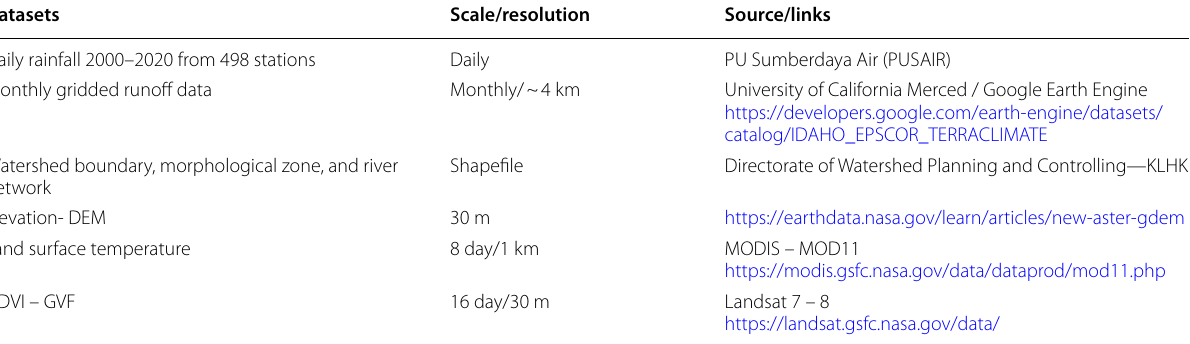
Table 1 List of datasets used in this study Datasets